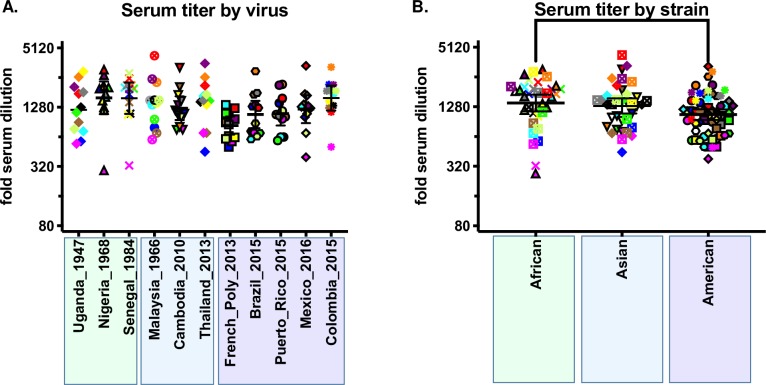
Neutralization by virus and strain.A) FRNT50 titers for each serum against each virus. The Y-axis shows fold-serum dilution, the X-axis shows each virus, the phylogenetic tree below the X-axis shows the relative genetic relatedness of the viruses. Individual virus symbols are indicated below the figure and the symbols are color-coded to match the sera in Fig 2. B) FRNT50 titers for ZIKV grouped by strain. Strain pairs found to be different by ANOVA followed by Tukey HSD correction for multiple comparisons are show by brackets (P = 0.038).